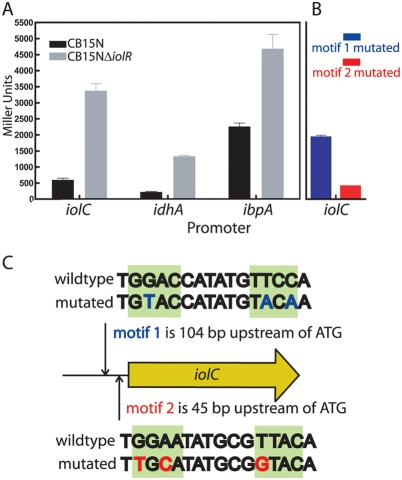
Regulation of genes in the myo-inositol module by the transcriptional regulator iolR and a conserved promoter sequence.(A) β-galactosidase assays of the idhA, ibpA and iolC promoters in the wild-type and ΔiolR backgrounds. (B) β-galactosidase assays of motif 1 (m1) and motif 2 (m2) mutated versions of the iolC promoter assayed in a wild-type background. The scale on the Y axis is the same for A and B. All β-galactosidase assays were conducted in PYE complex medium. (C) Schematic of the iolC promoter showing the location of the two conserved motifs; the wild-type and mutated versions of motif 1 are shown above the motif location map; wild-type and mutated versions of motif 2 are shown below.